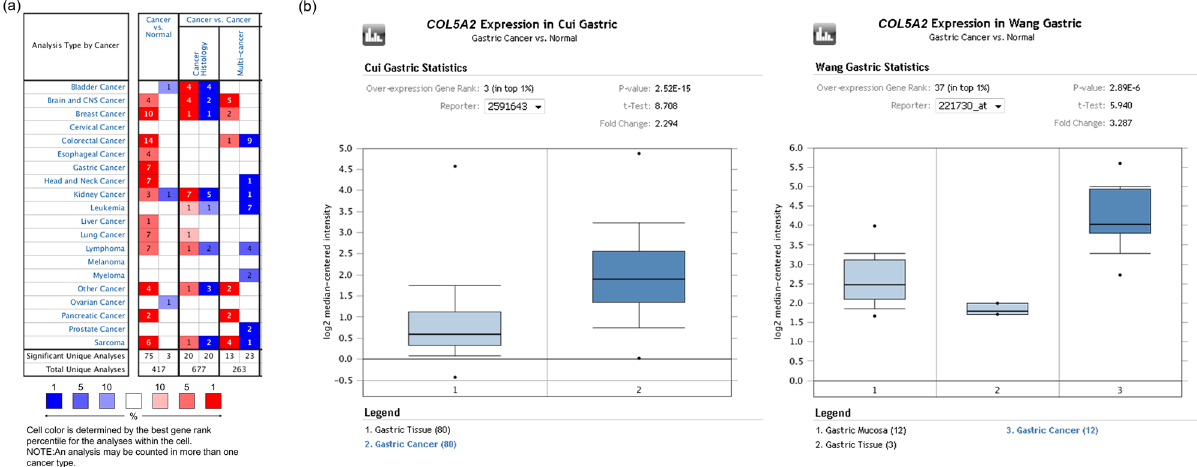
Figure 1: Oncomine analysis revealed that the mRNA expression of COL5A2 was up - regulated in GC. ( a ) mRNA expression of COL5A2 in a variety of cancers was analyzed, and COL5A2 expression was up - regulated in most tumor types. ( b ) mRNA expression of COL5A2 was evidently elevated in GC